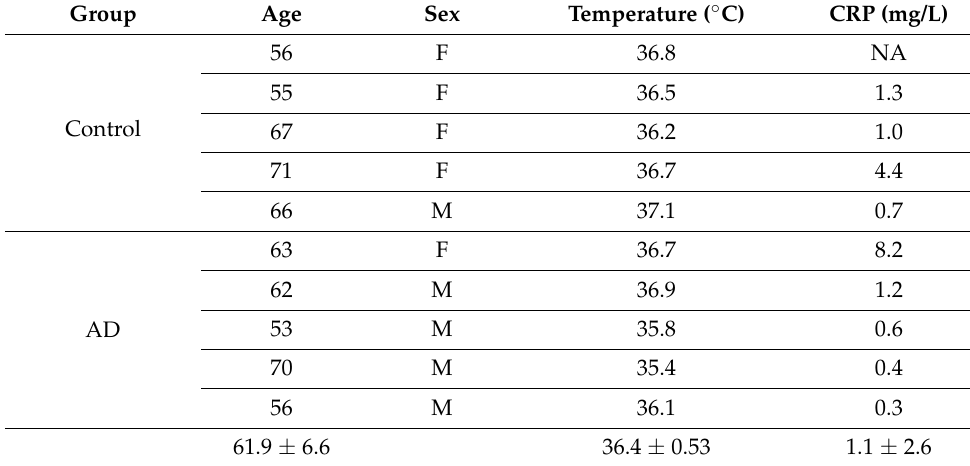
Table 3. Information for control and AD donors. CRP—C-reactive protein; AD—Alzheimer’s disease; NA—not